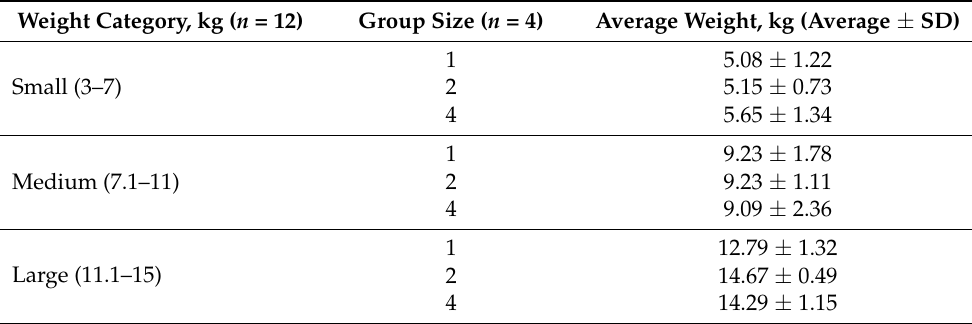
Table 1. Number of pigs and average weight exposed by weight category and group